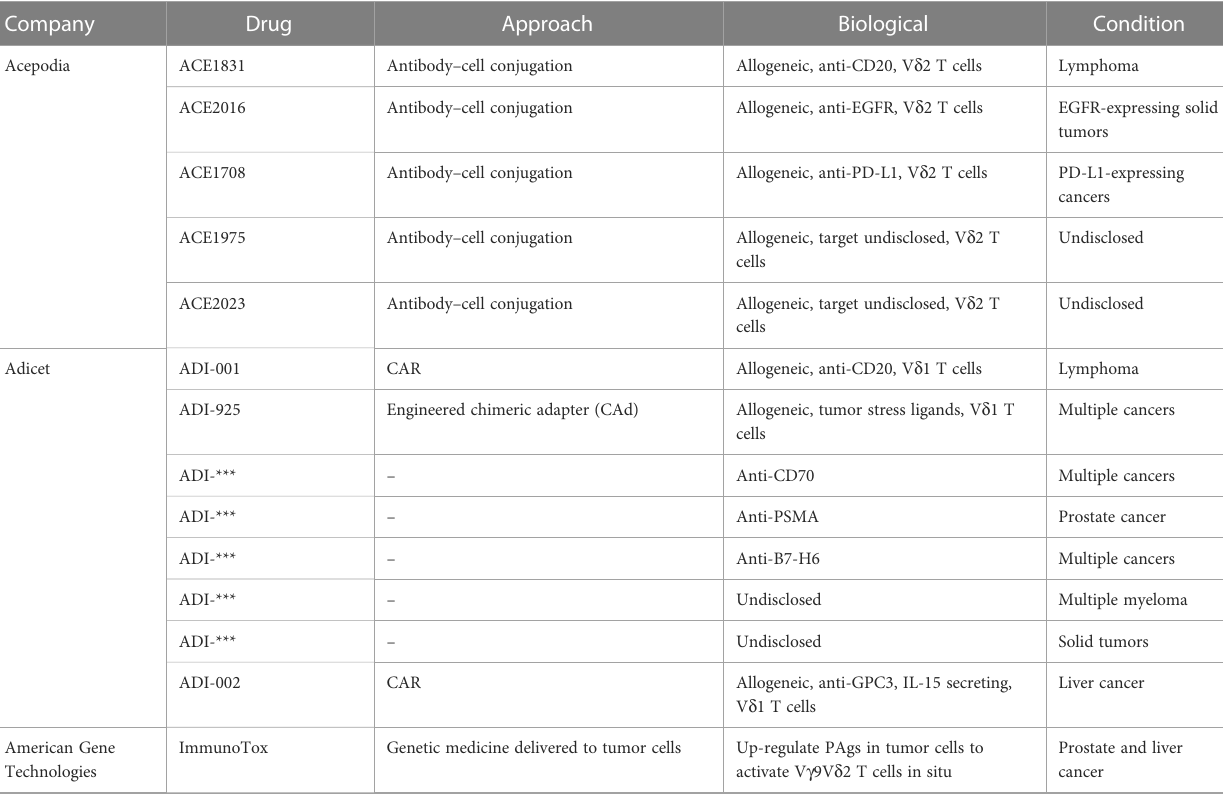
TABLE 6 Preclinical and clinical stage therapeutic gd T cells in the pharmaceutical industry.